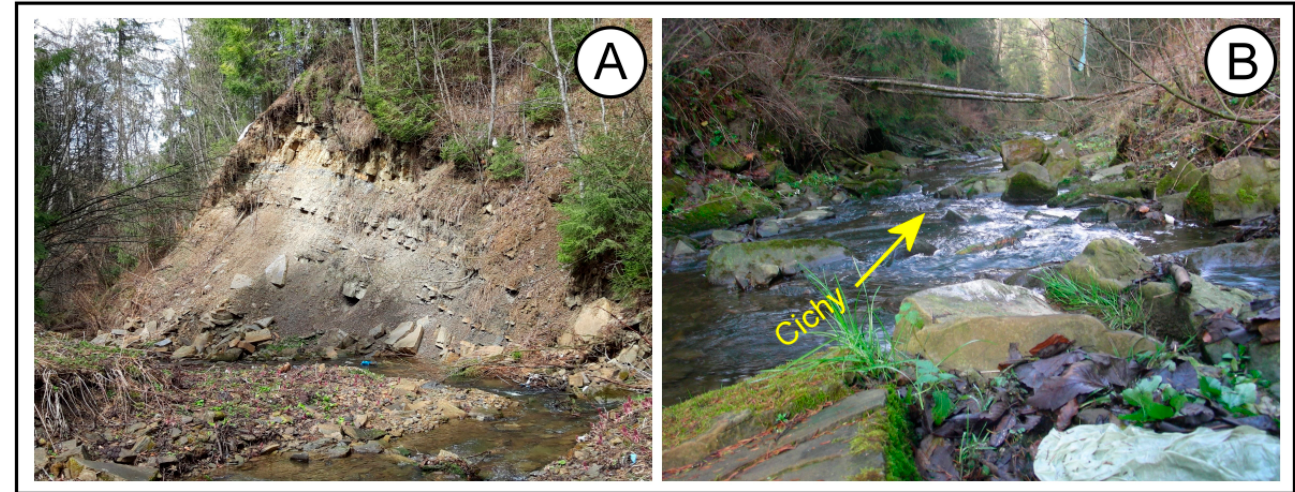
Figure 14. A slice of flysch rocks at the front of the Grapa landslide ( A ) and the channel of the Cichy River armored with the sandstone blocks eroded from the landslide front ( B ).